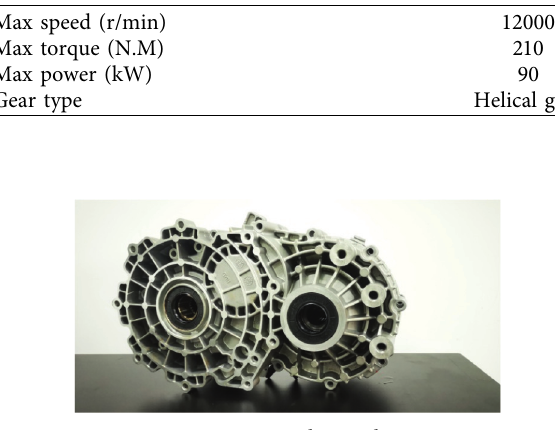
Figure 4: Secondary reducer.